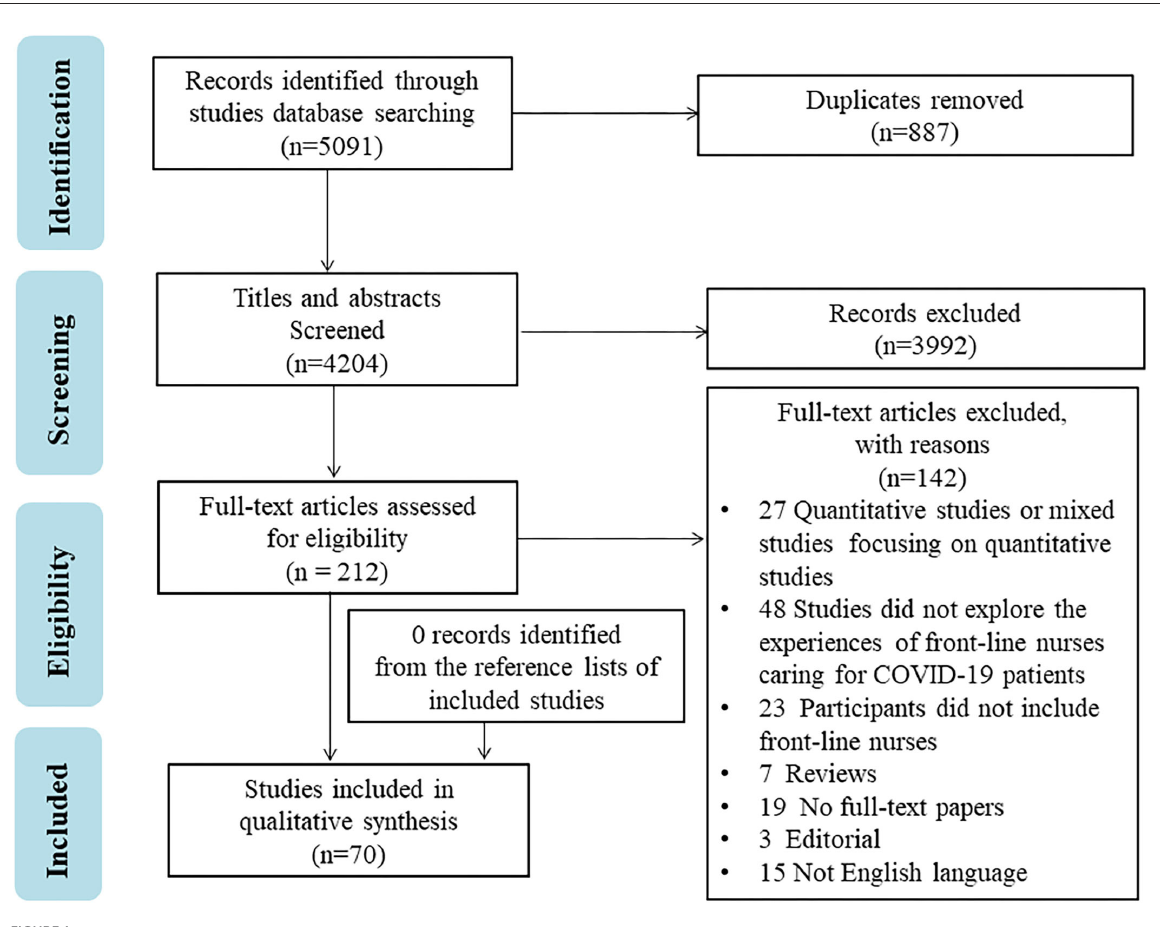
FIGURE1 Flow chart of search results and study